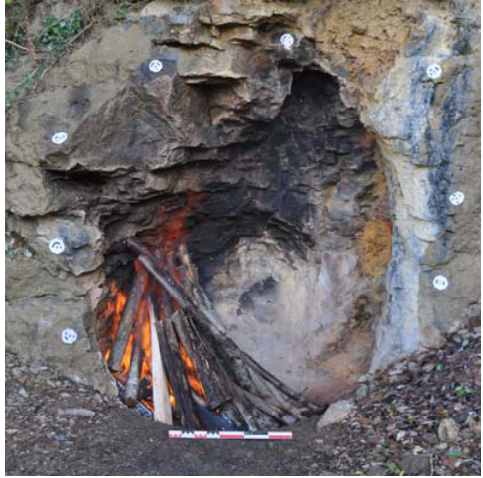
Figure 8. Experimental fire-setting on the scientific platform of the ‘Mines d’argent des Rois Francs’ in Melle Some 40 photos per phase were taken with a Nikon D90 and 18 mm lens. The orientation provides a coordinate residual of 2 mm on average. Each single surface model was calculated phase by phase with Agisoft Photoscan and exported for further analysis.